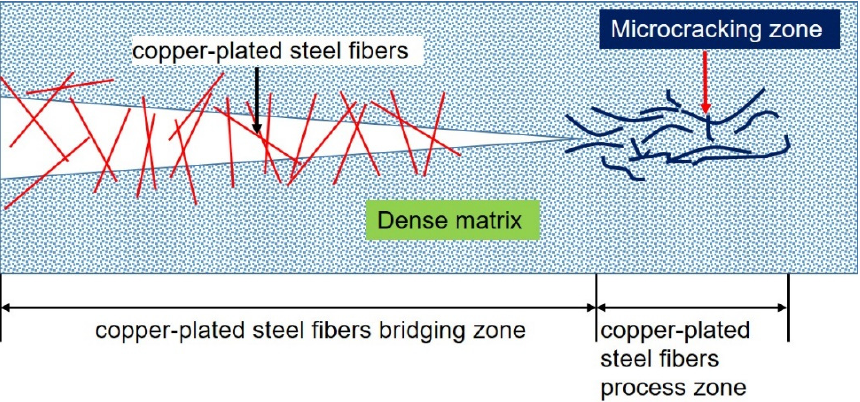
Figure 18. Schematic description of the relationship between BCSFs bridging and matrix